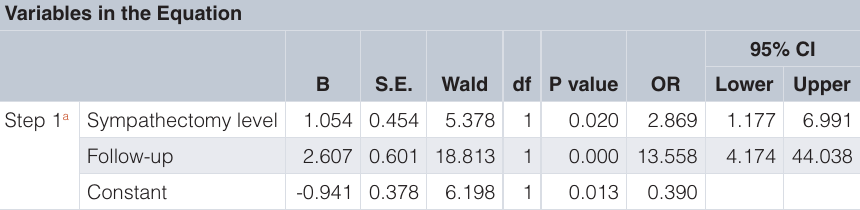
Table 8. Predictors of compensatory sweating (CS) in 118 subjects after endoscopic thoracic sympathectomy for primary hyperhidrosis at the National Heart Institute, Kuala Lumpur.